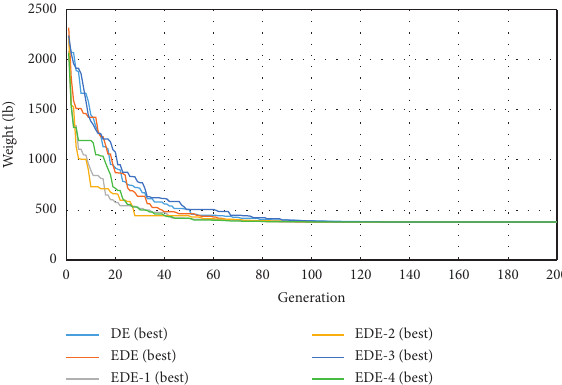
Figure 11: Convergence rates of DE, EDE, EDE-1, EDE-2, EDE-3, and EDE-4 for the 72-bar